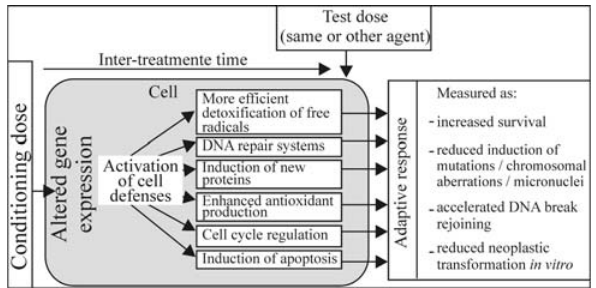
Figure 2 - Some underlying mechanisms probably involved in the adap- tive